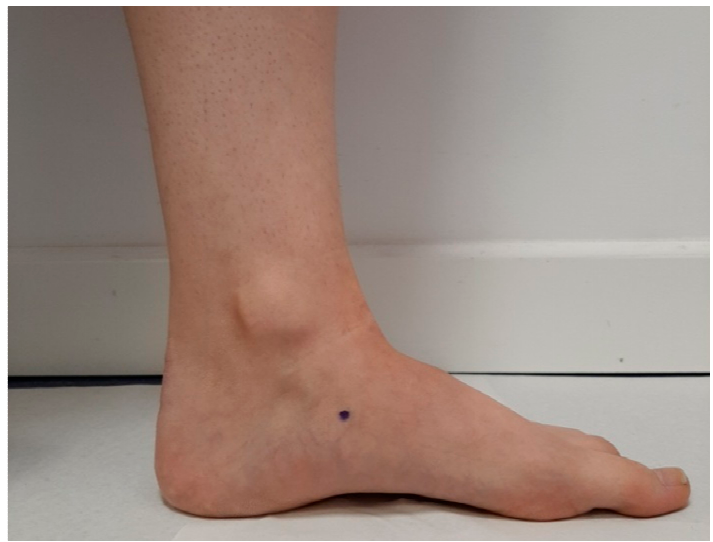
Figure 1. Signaling by a point of the most prominent aspect of the medial tuberosity of the navicular bone.